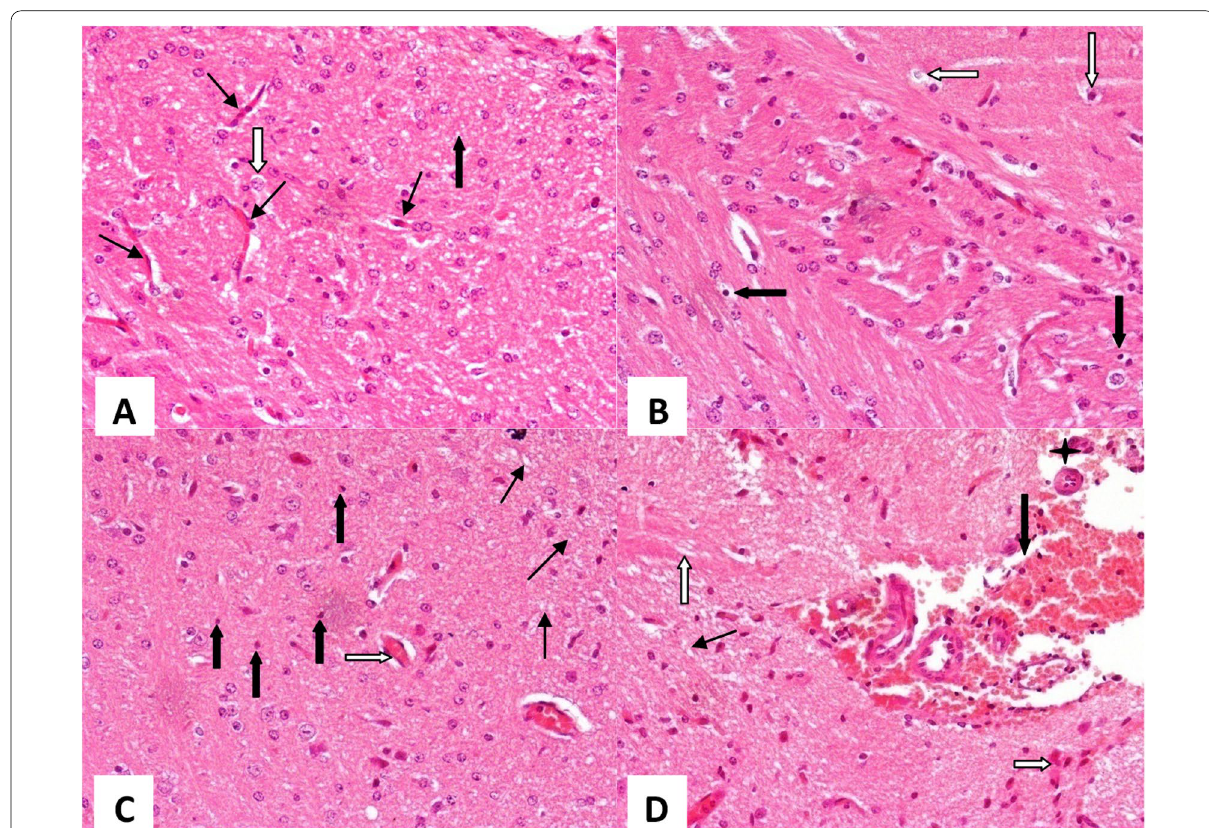
Fig. 5 A Brain tissue of mice treated with PQ showing scattered oligodendroglial cells (white arrow) amidst vacuolated degenerated background (thick black arrow). Scattered blood vessels were seen (thin black arrows) with absence of pigmented neuronal cells. B Brain tissue of mice treated with PQ showing scattered oligodendroglial cells (white arrows) with absence of pigmented neuronal cells. Pyknotic nuclei were seen (thick black arrows). C Brain tissue of mice treated with PQ showing hypocellularity and absence of pigmented neuronal cells. Several pyknotic nuclei were seen (thick black arrows). Vacuolated, degenerated background was noticed (thin black arrows) with ordinary blood vessels (white arrow). D Brain tissue of mice treated with PQ showing degenerated, vacuolated background with congestion (thick black arrow), thick walled blood vessels (star) and attempts at gliosis (white arrow) (H&E